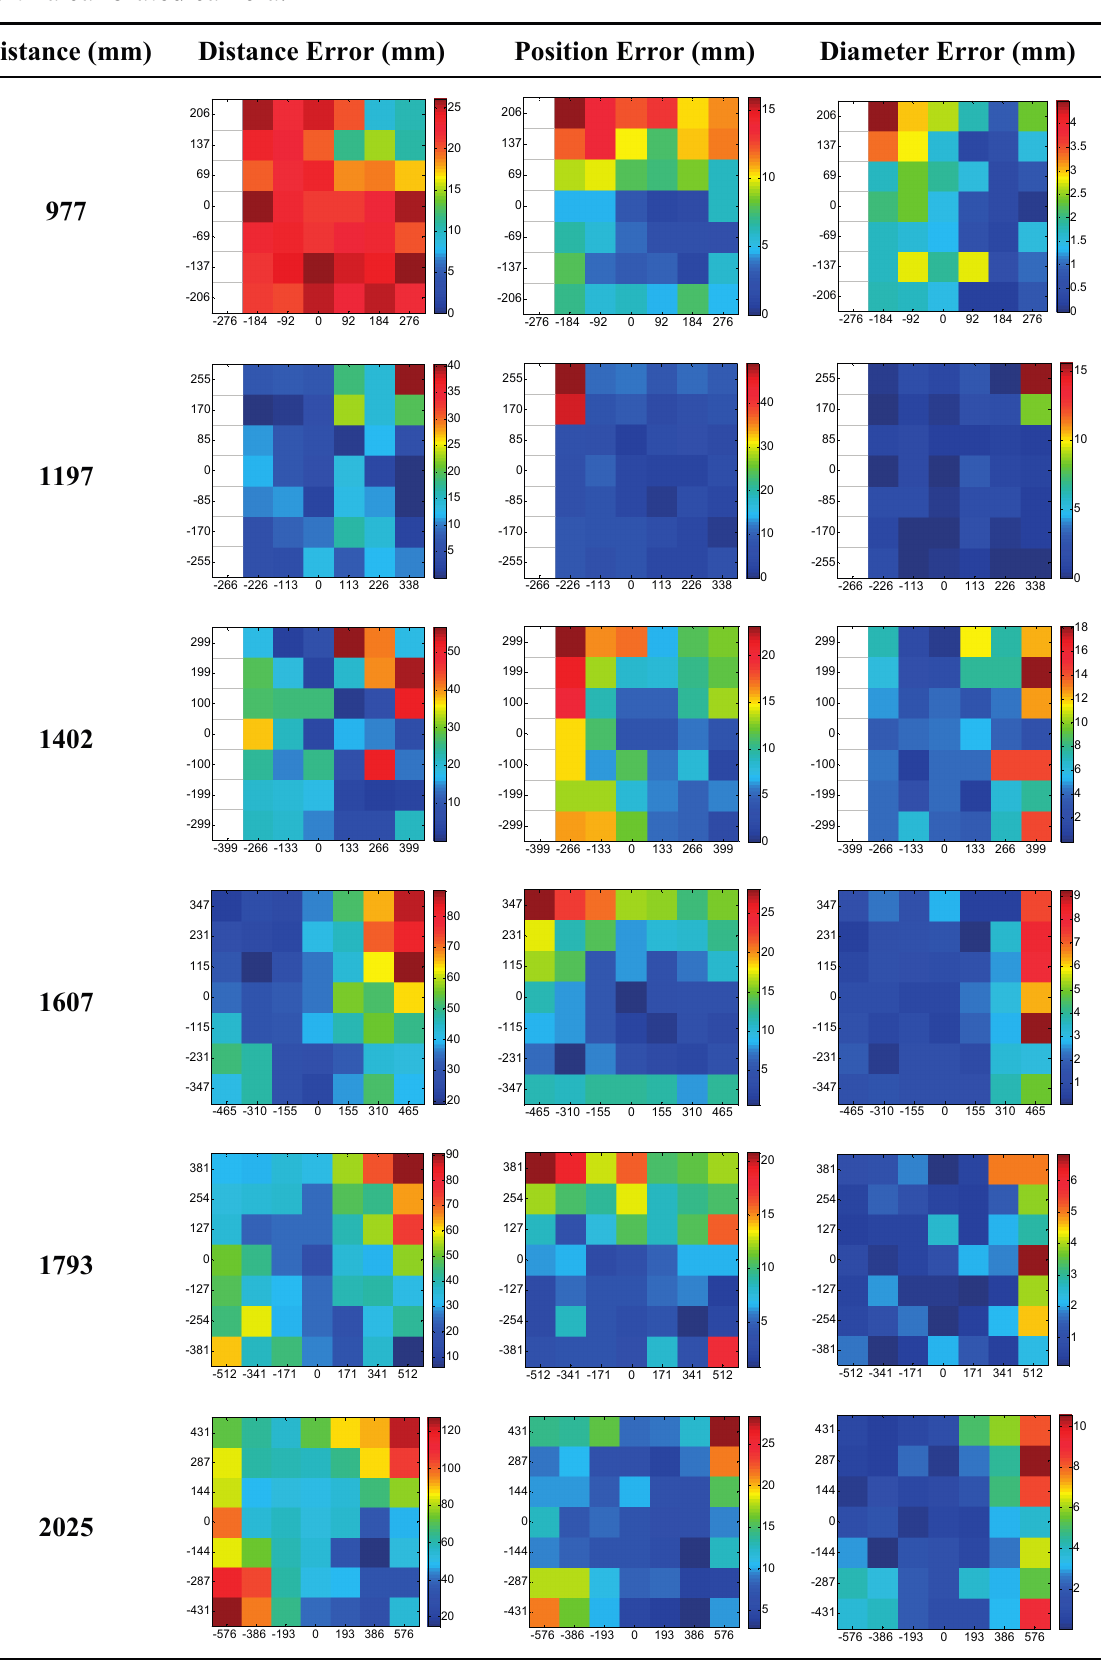
Table 7. Distribution of the errors in the measurement grid in case of detecting an apple with a calibrated